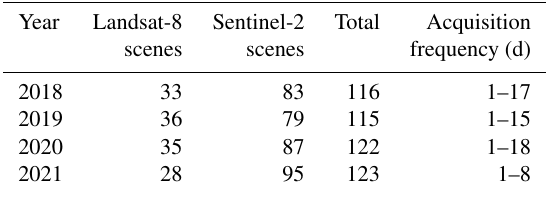
Table 4. Number of Sentinel-2 and Landsat-8 images used for anal-